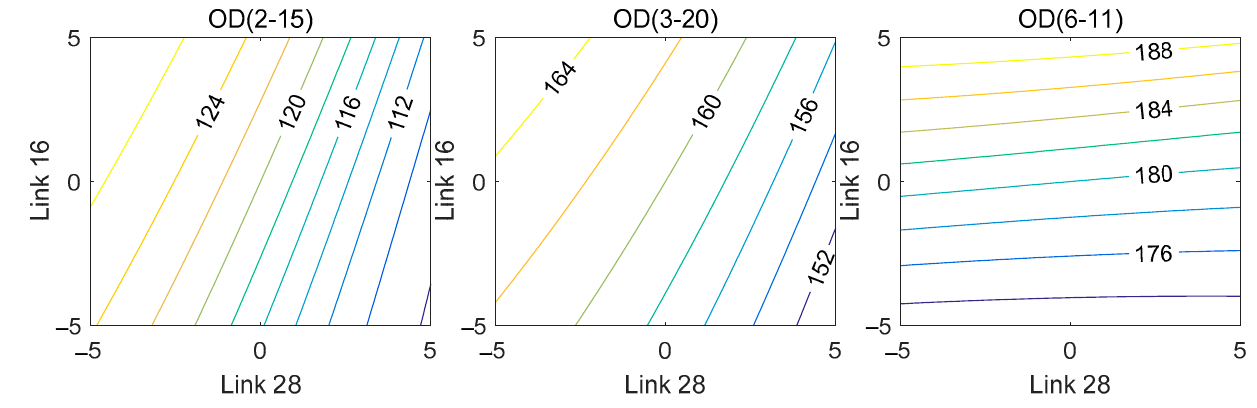
Figure 6. Traffic demands between different OD pairs under fluctuations of observed data on links 16 and 28.